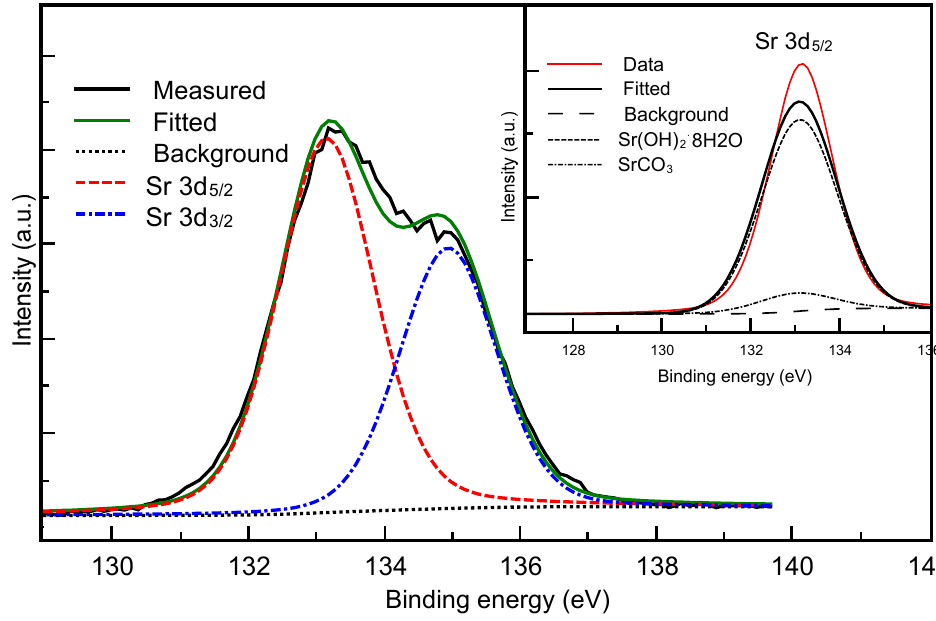
Figure 3. XPS spectrum of Sr 3d 5/2 and Sr 3d 3/2 for the SrCO 3 ‐ Sr(HO) 2 sample. The inset shows the deconvolution of the Sr 3d 5/2 signal.